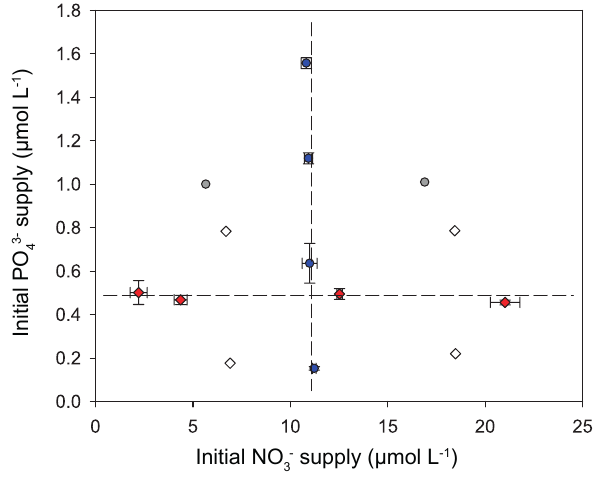
Figure 1. Experimental design and initial nutrient supply conditions during varied P (blue circles) and varied N (red diamonds). “Cor- nerpoints” during varied P and varied N are depicted as gray circles and white diamonds, respectively. Error bars denote the standard deviation of replicated ( n = 3)